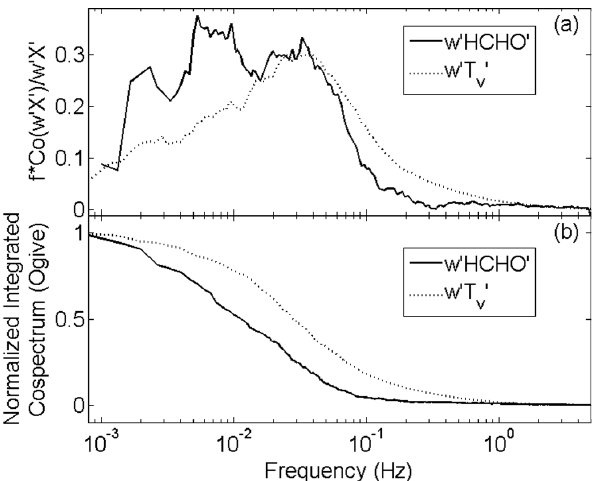
Fig. 3. (a) Averaged, frequency-weighted, covariance-normalized cospectra for half-hour periods from 10:00 to 14:00 over entire measurement period. Cospectra were binned into 200 bins spaced equally in logarithmic frequency space, and each bin was averaged. (b) Averaged ogives for half-hour periods from 10:00 to 14:00 over entire measurement period.